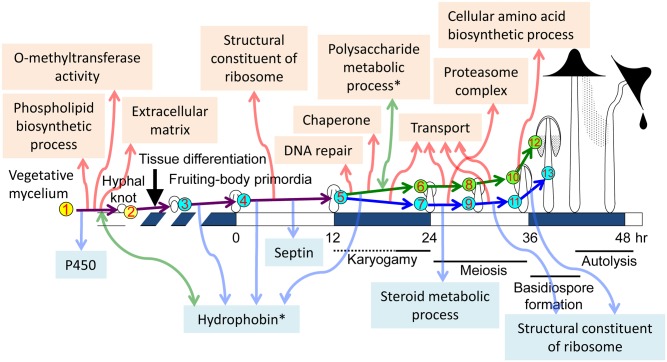
A model for significant developmental transitions based on GO analysis.Notable events among top 3 categories are depicted in fruiting. Events detected by up-regulated DEGs and down-regulated DEGs are indicated in the upper part with upward red arrows and in the lower part with downward blue arrows, respectively. The asterisks and bidirectional light green arrows indicate that similar annotation terms are enriched in both up-regulated and down-regulated DEGs.